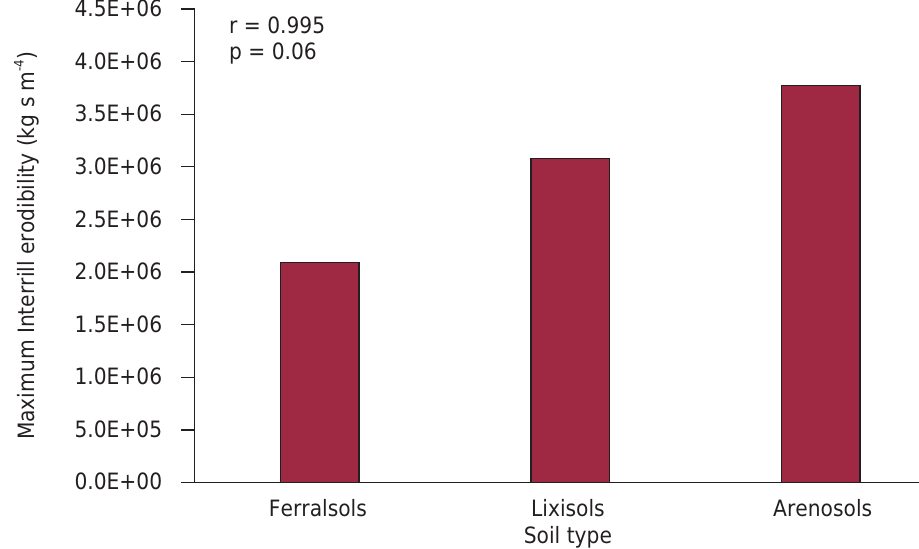
Figure 3. Increase of maximum interrill soil erodibility following the soil position on the catena: Ferralsols (summit), Lixisols (mid-slope), and Arenosols